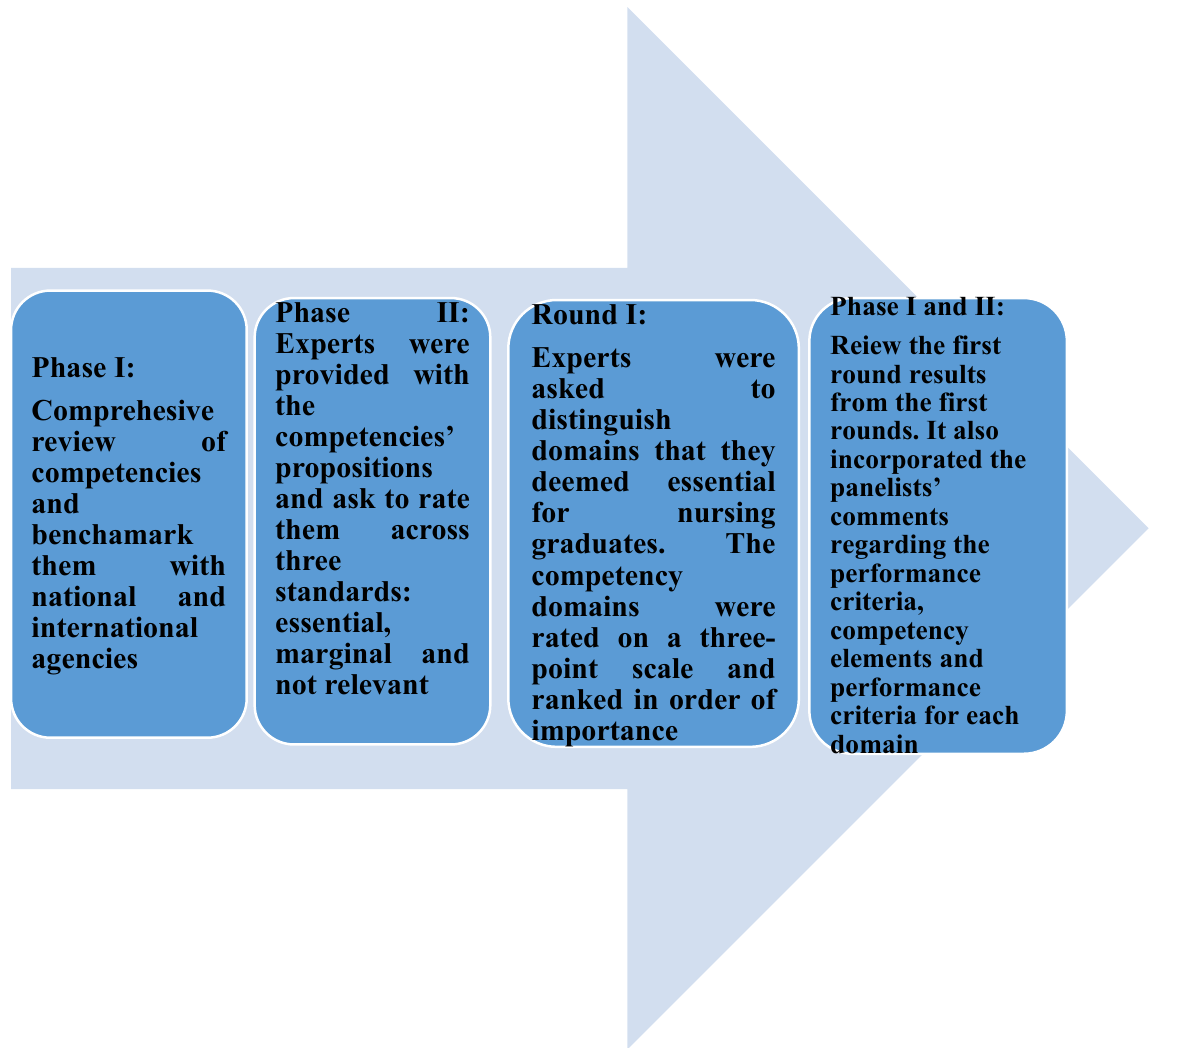
Figure 1. Phases of Development of Nursing professional framework.